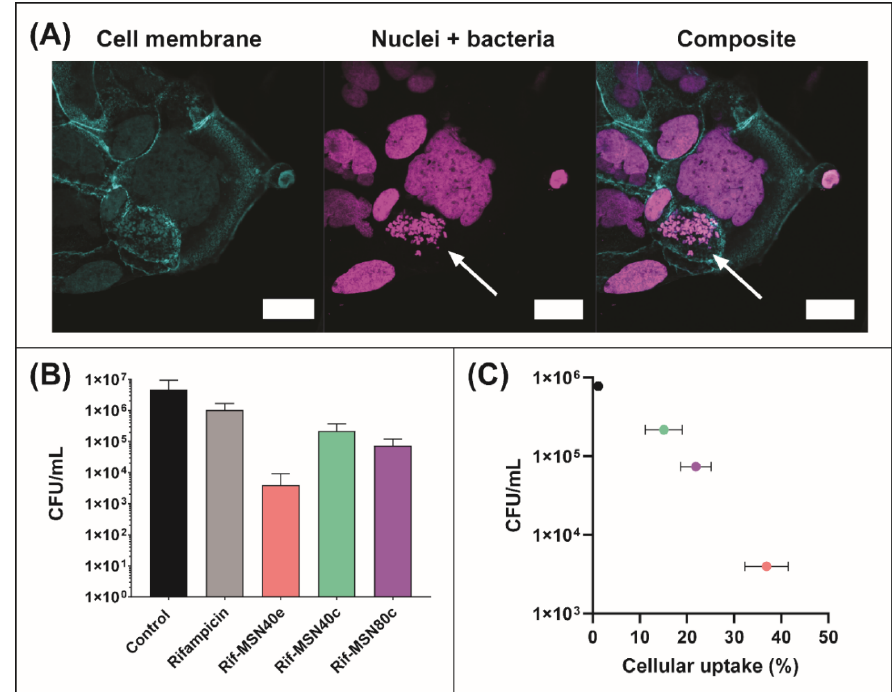
Figure 4. ( a ) Laser scanning confocal fluorescence micrographs of SCV S. aureus -infected Caco-2 cells. SCV S. aureus and nuclei were labelled with DAPI (magenta) and the cell membrane was labelled with Alexa-488 (cyan). Intracellular pathogens are highlighted by the arrow. ( b ) Efficacy of the following rifampicin formulations in the reduction of intracellular SCV S. aureus within Caco-2 cells: rifampicin solution (grey bar), MSN40e (pink bar), MSN40c (green bar), and MSN80c (purple bar), relative to a control group (i.e., no treatment; black bar). ( c ) Colony forming units of intracellular pathogens as a function of cellular uptake of each formulation (from data already presented).